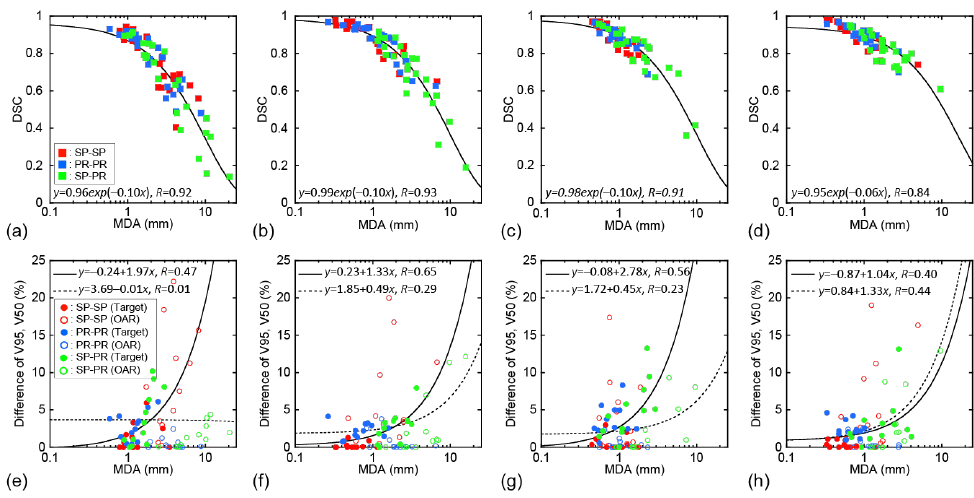
Figure 4. Correlations between mean displacement to agreement (MDA) and DSC ( a – d ), and MDA and absolute difference of V95 of CTV and GTV or V50 of stomach and duodenum ( e – h ). Red markers show the results of SP-SP cases, blue markers PR-PR cases, and green markers SP-PR cases. Squares represent target (CTV and GTV) and organs at risk (OARs) (stomach and duodenum), filled circles represent target, and hollow circles OAR. ( a , e ) show RIR, ( b , f ) show iDIR, ( c , g ) show cDIR, and ( d , h ) show hDIR. The black line in ( a – d ) indicates a regression curve fitted with an exponential function. The black and black-dotted lines in ( e – h ) show regression lines fitted with a linear function for the target and OAR, respectively.